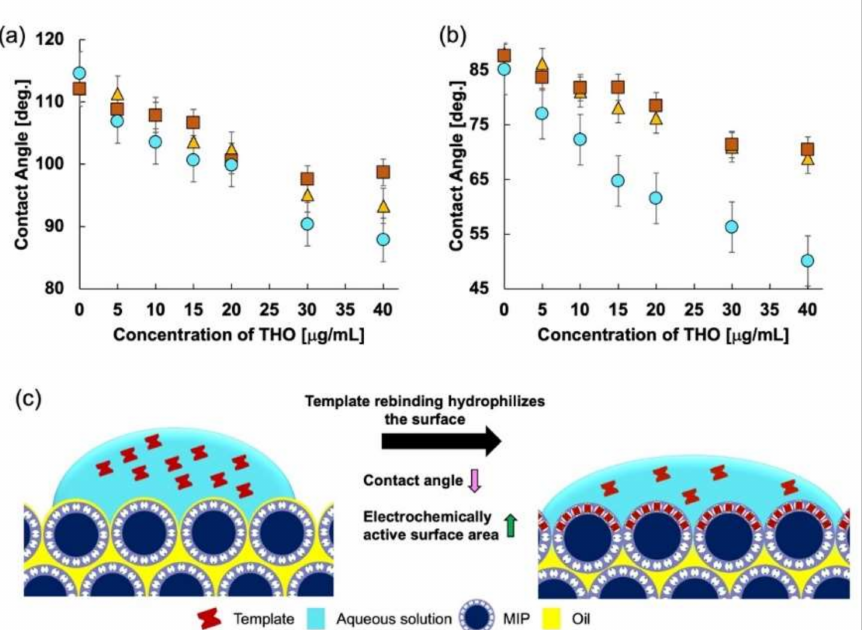
Figure 2. ( a ) Advancing contact angle of the three MIPs, ( b ) receding contact angle of the three MIPs: squares, triangles, and circles represent MIP 1, MIP 2, and MIP 3, respectively, and ( c ) illustration of the decreasing contact angle with increasing MIP rebinding. As the template rebinds with the MIP, the surface is hydrophilized and thus the contact angle